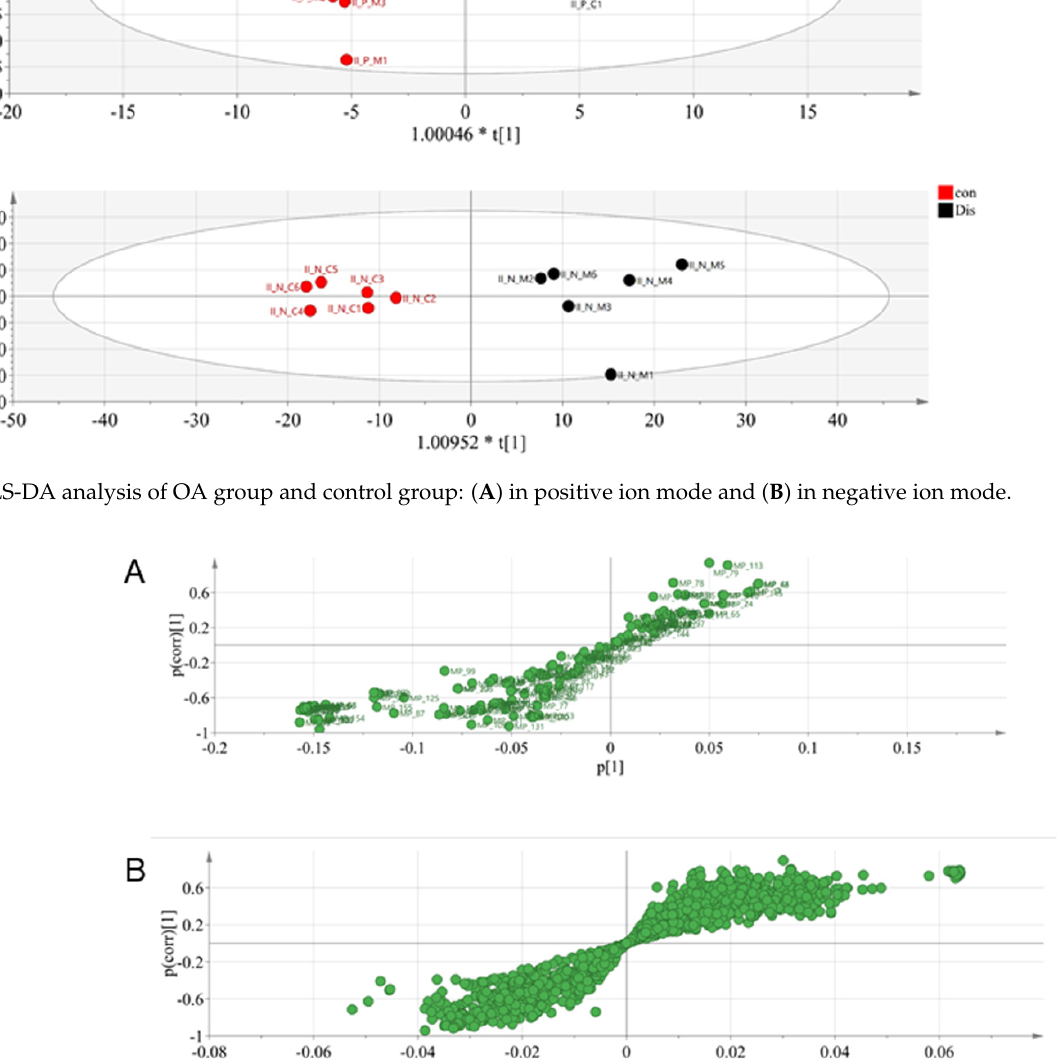
Figure 4. S-plot constructed from serum samples of OA group and control group: ( A ) in positive ion mode and ( B ) in negative ion mode.